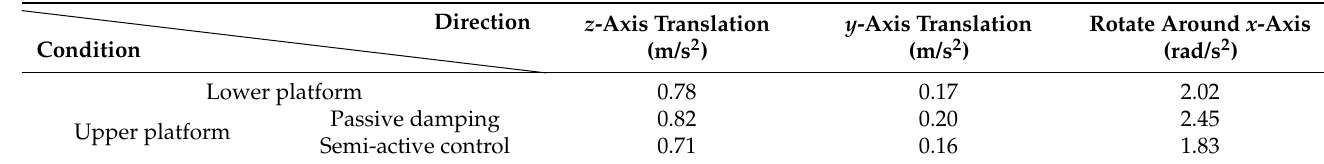
Figure 28. Simulation results of the angular acceleration around the x -axis direction. Table 4. Simulation results (RMS value) of the multi-DOF damping seat